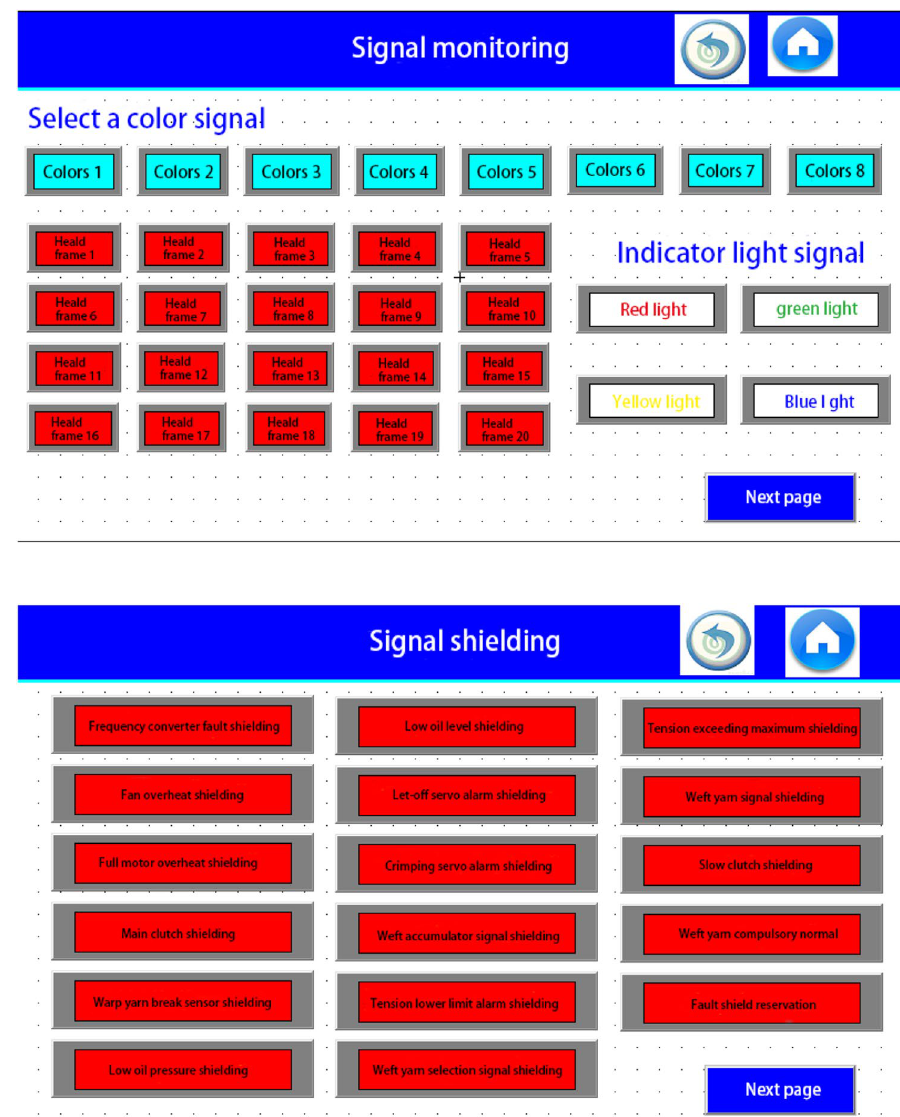
Fig. 23 Signal monitoring interface